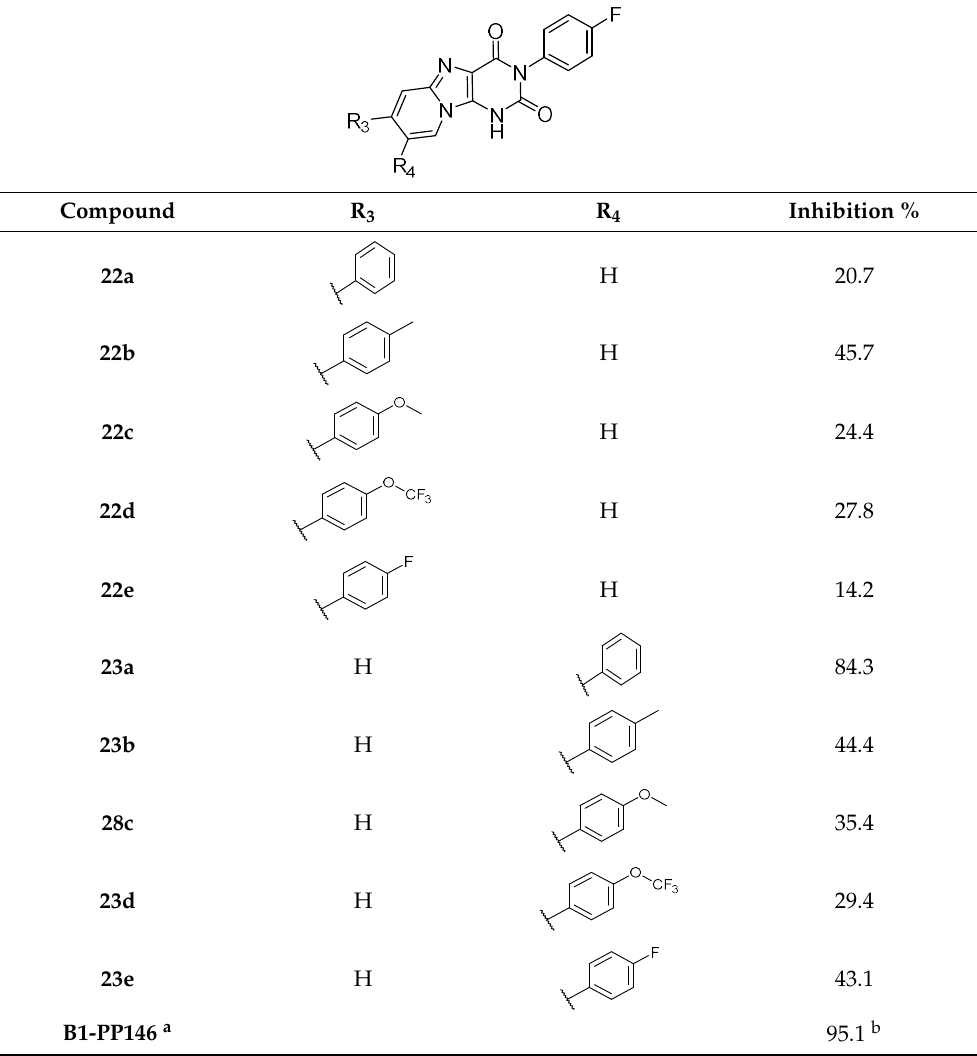
Table 6. SAR of the C 7 and C 8 moiety by the Suzuki‒Miyaura cross-coupling and Mtb ThyX inhibition at 200 µM by the NADPH oxidase assay.